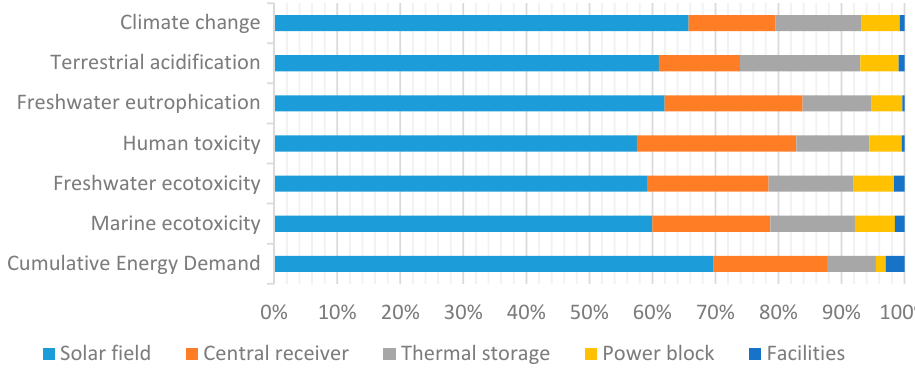
Figure 3. Relative contribution of the manufacturing phase systems to the characterized impacts of the reference HYSOL plant.